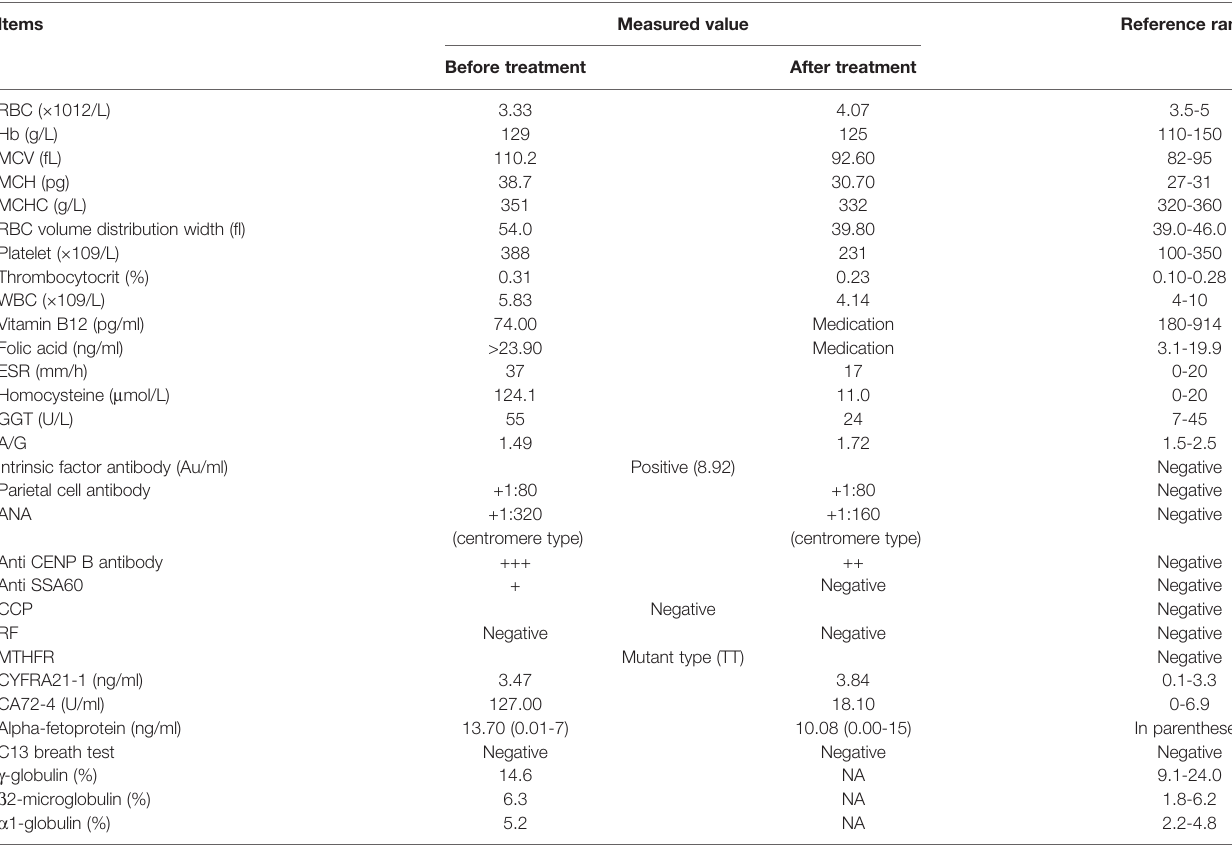
TABLE 1 | Laboratory test results before and after treatment. Items